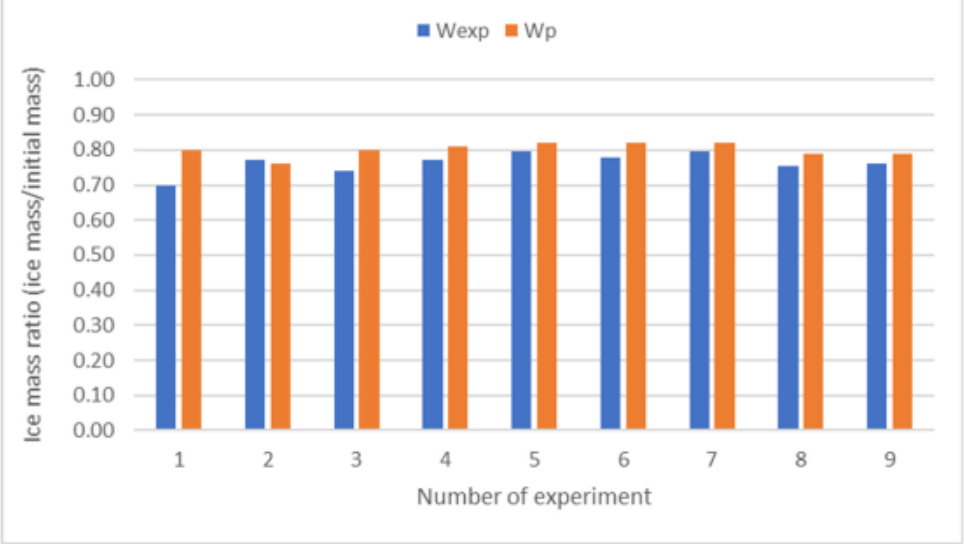
Figure 5. Experimental (W exp ) and predicted (W p ) values of ice mass ratio for CSW1 (experiment number 1, 2, and 3), CSW2 (experiment 4, 5, and 6), and CSW3 (experiment 7, 8, and